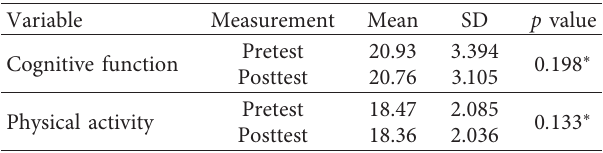
Table 4: Mean difference (mean) score of cognitive function and physical activity pretest and posttest in the control group in Dago Village Community Health Center working area.